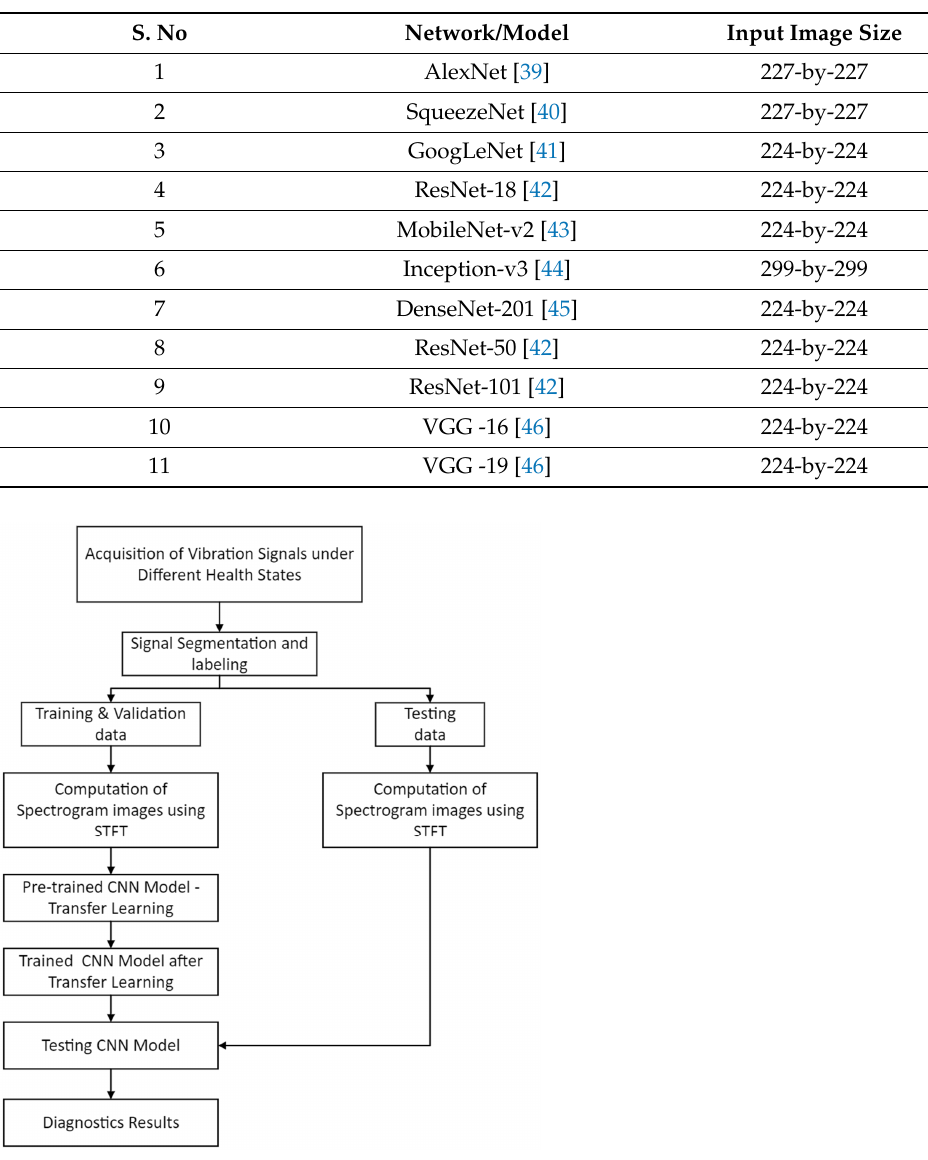
Figure 5. Method-I. Figure 5.